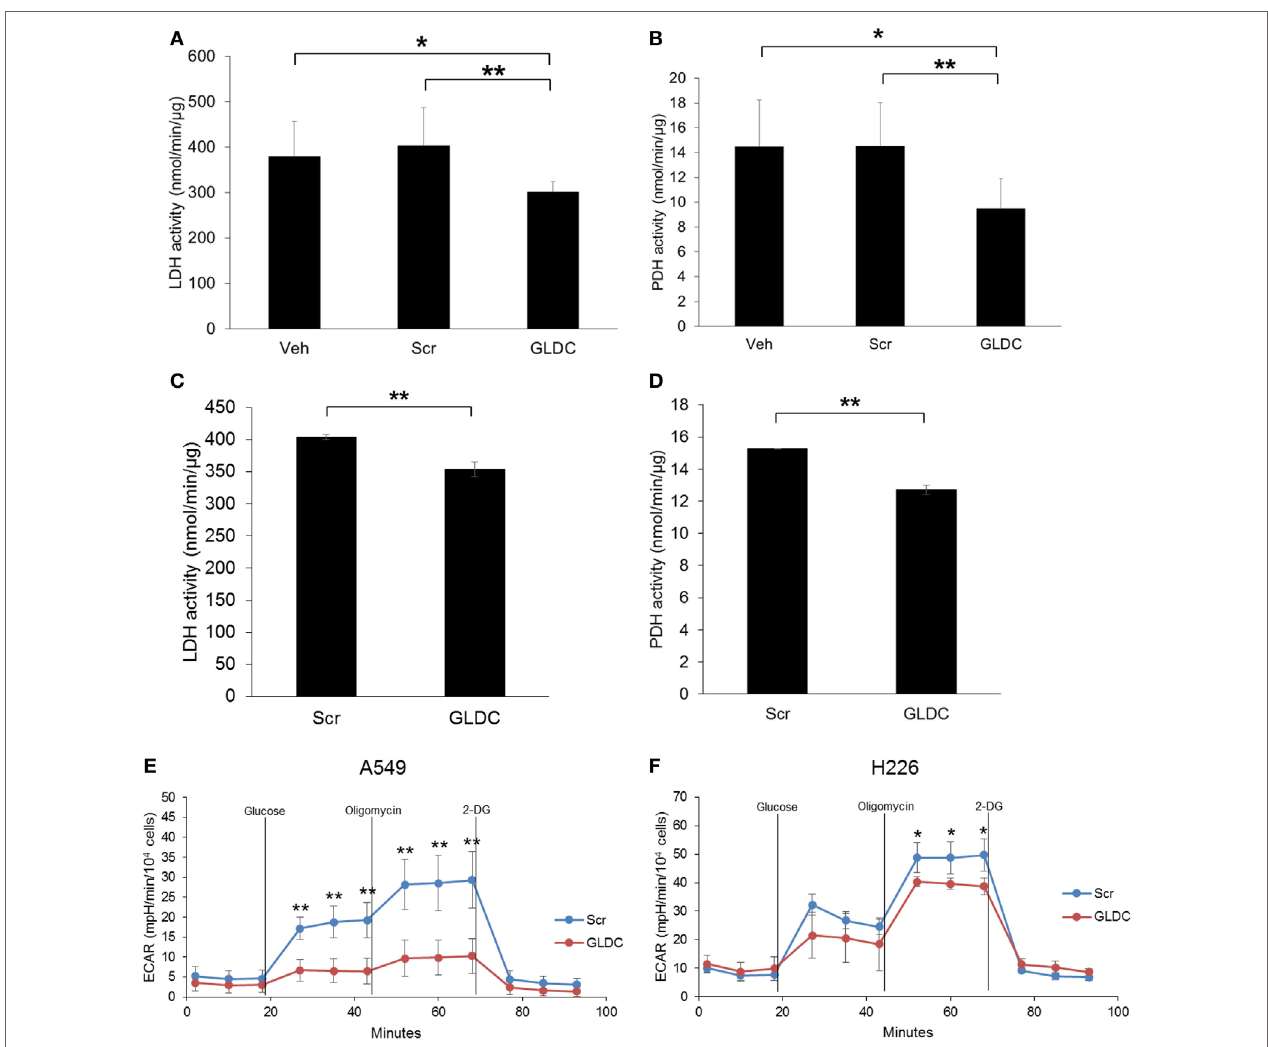
FigUre 5 | Glycine decarboxylase (GLDC)-steric hindrance antisense oligonucleotide (shAON) treatment inhibits lactate dehydrogenase (LDH) and pyruvate dehydrogenase (PDH) activities as well as reduces lactic acid production. Measurement of (a) LDH and (B) PDH activities in the tumor tissues of all treatment groups. Data represent mean ± SD (* p < 0.05 and ** p < 0.01). Measurement of (c) LDH and (D) PDH activities in shAON-treated H226 and A549 cells, respectively. Data represent mean ± SD (** p < 0.01). Glycolysis stress test to measure the extracellular acidification rate in (e) A549 and (F) H226 cells after 3 days of shAON treatment. Data represent mean ± SD (* p < 0.05 and ** p <